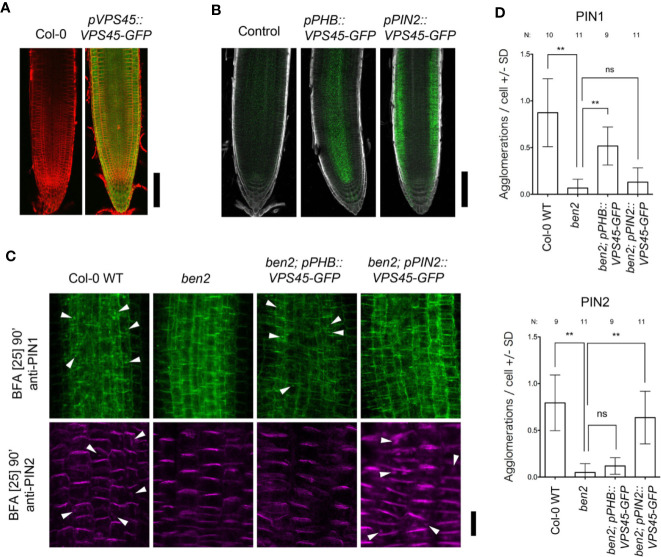
BEN2/VPS45 regulates PIN trafficking cell-autonomously. (A) Root tips of Col-0 and pVPS45::VPS45-GFP at 7 DAG. (B) Root tips of ben2 single mutant (control) and ben2 mutants harboring pPHB::VPS45-GFP and pPIN2::VPS45-GFP constructs at 7 DAG. (C) Immunolocalization of PIN1 and PIN2 in BFA-treated Col-0, ben2, ben2; pPHB::VPS45-GFP, and ben2; pPIN2::VPS45-GFP seedlings. PIN1 localization in vasculature (green signals in upper panels) and PIN2 in epidermis (magenta signals in lower panels) are indicated. Arrowheads indicate agglomeration of PIN proteins. Representative images from at least three independent experiments are shown. (D) Quantification of PIN1 and PIN2 agglomeration in the BFA-treated seedling roots. Number of agglomeration (>1 µm2 in cross section) per cell was scored in at least 10 cells in each root. Data from 9 to 11 seedling root (187–378 cells) from each genotype were evaluated. Asterisks (**) represent significant difference (p-value ≤ 0.01 by Student's t-test). Scale bars: 100 µm in (A, B) and 20 µm in (C).